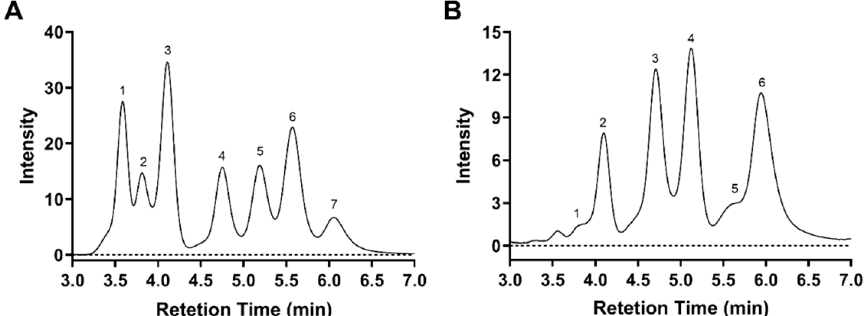
Figure 2. Monosaccharide composition of As sP. ( A ) Chromatogram of monosaccharide standard: 1, galactosamine; 2, rhamnose; 3, arabinose; 4, galactose; 5, glucose; 6, mannose; 7, fructose. ( B ) Chromatogram of As sp with peak identity: 1, rhamnose; 2, arabinose; 3, galactose; 4, glucose; 5, mannose; 6, fructose.